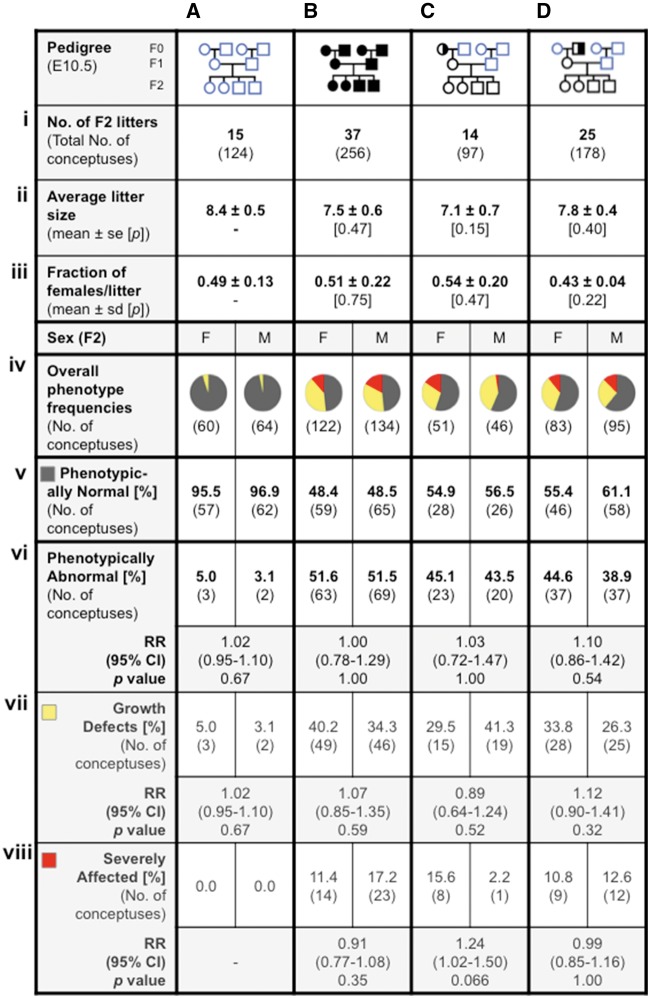
developmental phenotypes at E10.5 in Mtrrgt pedigrees are not sexually dimorphic. Conceptuses from the following pedigrees were analyzed at E10.5 in columns: (A) C57Bl/6 control conceptuses, (B) Mtrrgt/gt conceptuses, and (C and D) F2 wild-type conceptuses derived from a wild-type mother and either (C) an Mtrr+/gt maternal grandmother or (D) an Mtrr+/gt maternal grandfather. (i) The number of litters and total number of conceptuses assessed are indicated; (ii) the average litter size for each pedigree is indicated (mean ± standard error (se)); and (iii) average number of females per litter (±standard deviation (sd)) were calculated. In each case, independent t tests were performed to compare C57Bl/6 values to each experimental pedigree. (iv–viii) For each sex per pedigree, phenotypic frequencies were determined and represented graphically and as percentages. Two main phenotypic groups were assessed: (v) phenotypically normal and (vi) abnormal conceptuses. The percentage of phenotypically abnormal conceptuses was subdivided into two phenotypic groups: (vii) those with growth defects (e.g. growth enhanced, growth restricted, or developmental delayed) and (viii) those that were severely affected with at least one congenital malformation (e.g. neural tube, heart, and/or placenta defects). (iv) Pie charts show the proportion of conceptuses per sex that appeared phenotypically normal (grey), had a growth defect (yellow), or were severely affected (red). (v–viii) Relative risk (RR) was calculated between male and female conceptuses within each phenotype per pedigree. The 95% CI is indicated along with the P value as determined by a two-tailed Fisher test. F, female; M, male. Pedigree key: circle, female; square, male; blue outline, C57Bl/6 line; black outline, Mtrrgt line; white fill, Mtrr+/+; half black/half white fill, Mtrr+/gt; black fill, Mtrrgt/g.